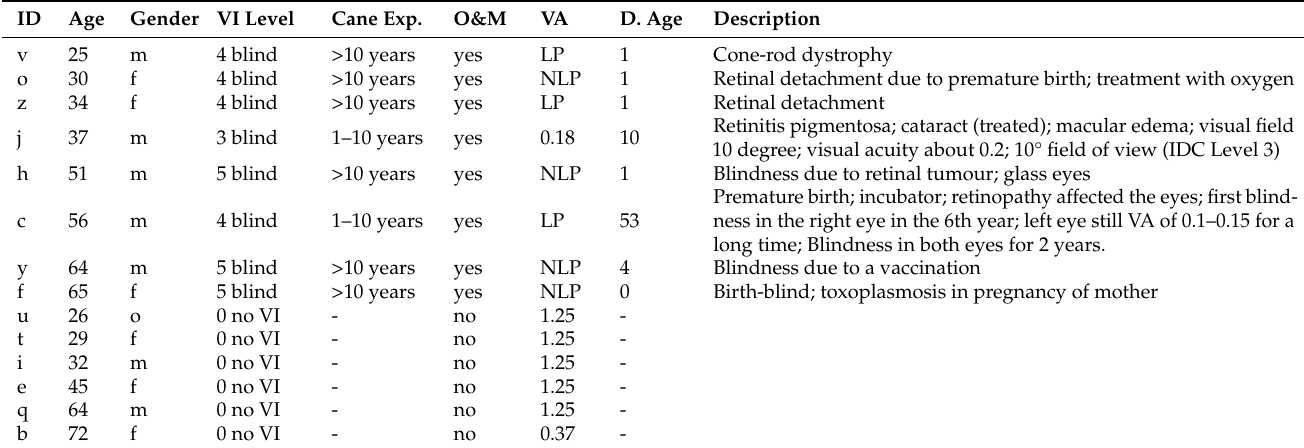
Table A2. Summary of the subject data. Column name abbreviations: ID = subject identifier; VI